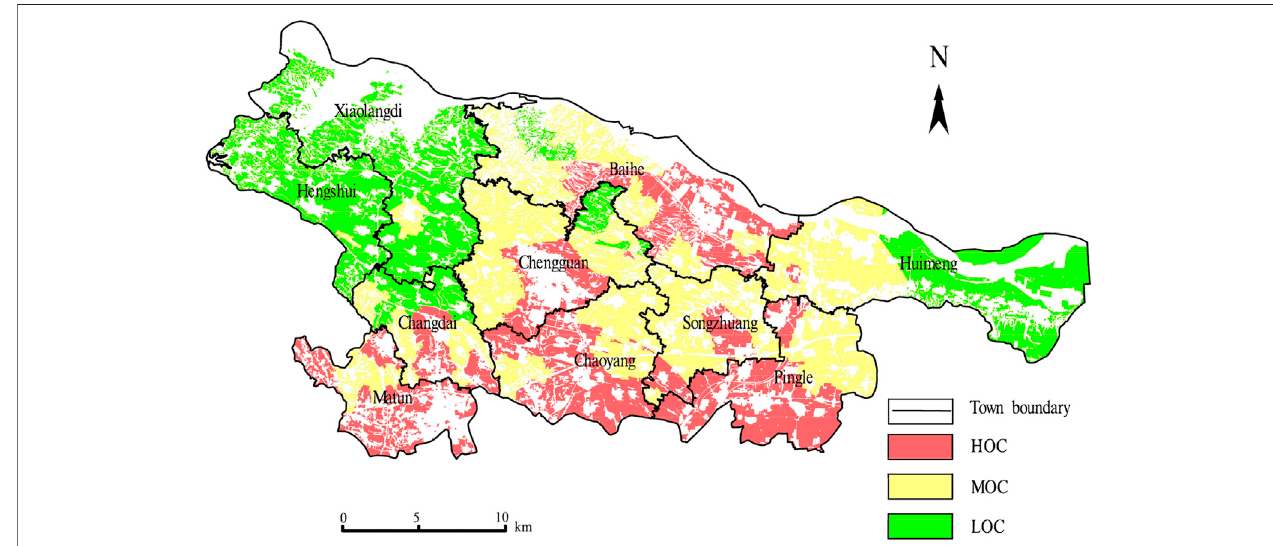
FIGURE 5 | Map of the spatial distribution of opportunity cost of farming in Mengjin